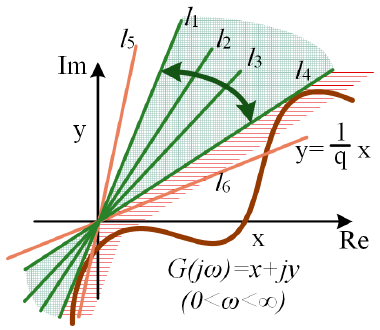
Figure 6. ( ) G jw satisfying the Popov condition on the complex plane. Figure 6. G ( jw ) satisfying the Popov condition on the complex